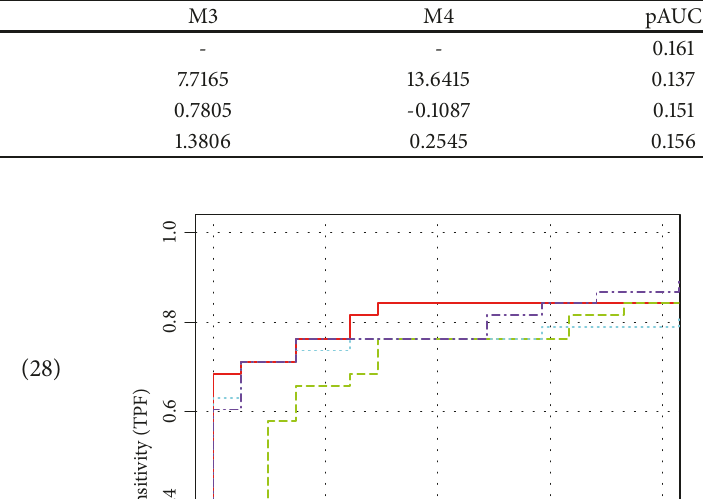
Table 5: The coefficients of the optimal linear combination and the corresponding estimated